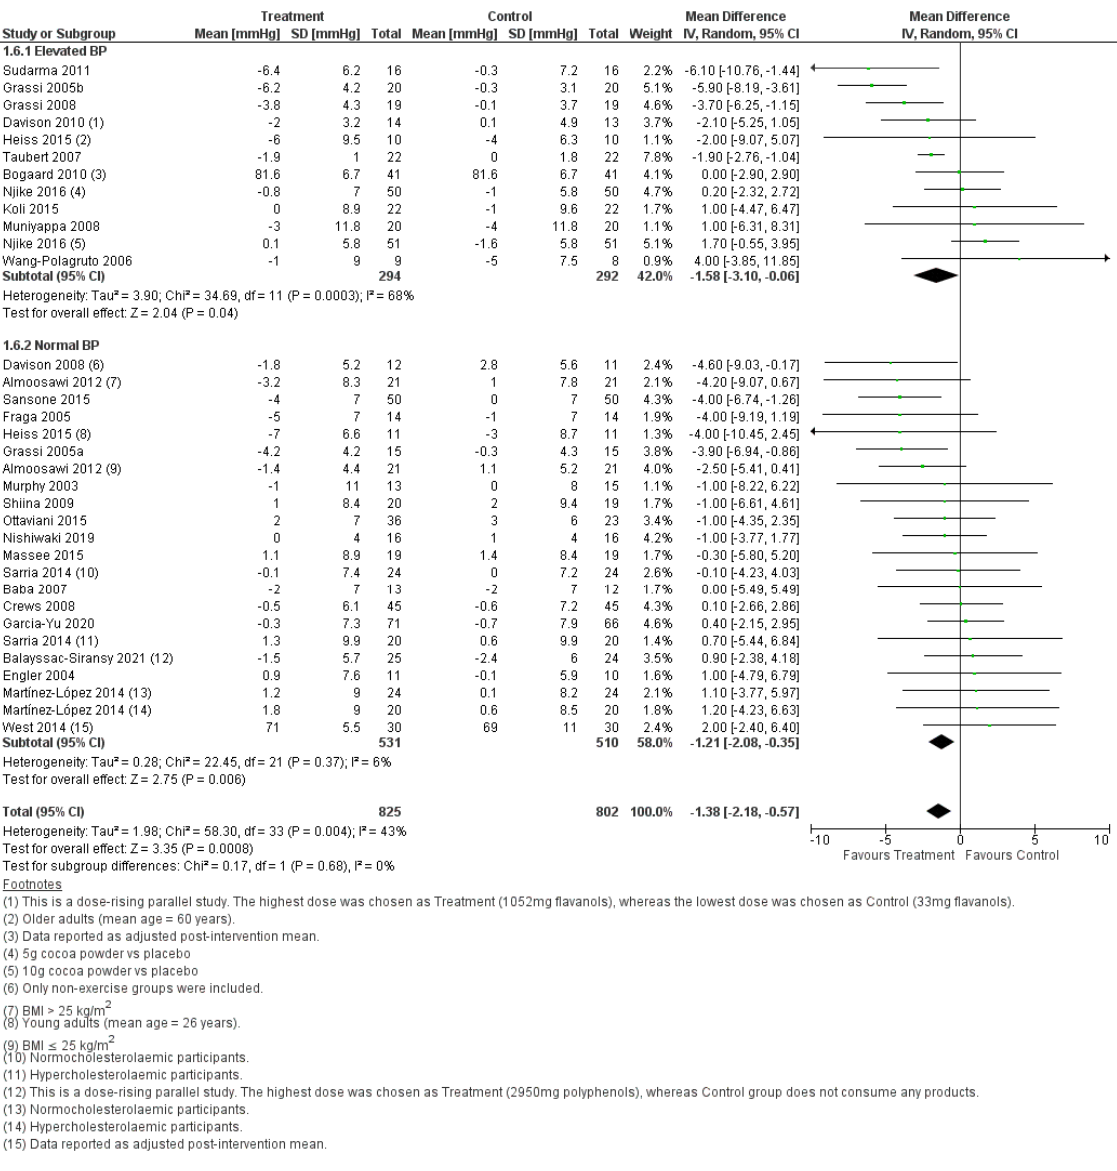
Figure 5. Forest plot showing the pooled effect of cocoa consumption on resting diastolic BP.